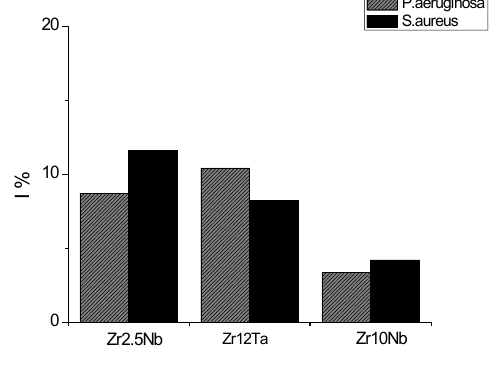
Figure 6. The bacterial inhibition growth for the three Zr-binary